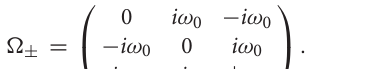
β ω 1 1 / √ 2, ω 0 1. The dependence = = = =